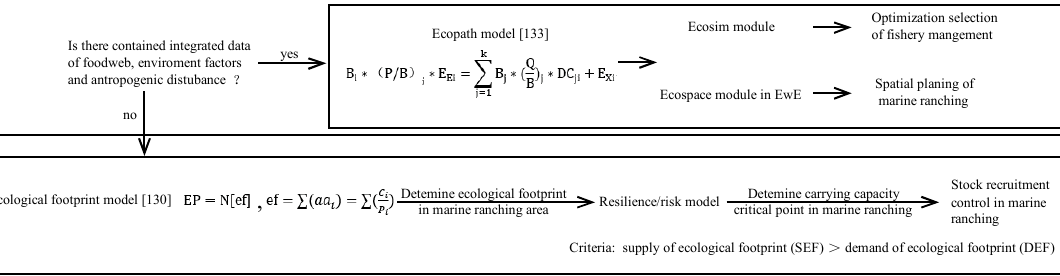
Figure 5. An example of strategic model selection based on sufficient and limited data using the Ecopath with Ecosim (EwE) model and the ecological footprint model, respectively. Note: in the ecopath model, (P/B) i is the ratio between production and biomass of group i, (Q/B) i is the ratio between consumption and biomass of group i, DC ij is the proportion predator i in total consumption of prey j, EX i is the production (including the catch and net outflow). In the ecological footprint method, i is the primary or secondary producer in marine ranching, P i is the primary or secondary production in marine ranching, C i is the introduced species i’s average consumption biomass to primary or secondary production, αα i is the mean production area of the introduced species consumption to primary production i, N is the number of introduced species, ef is the mean ecological footprint of the introduced species, and EP is the total ecological footprint [18,129,132].